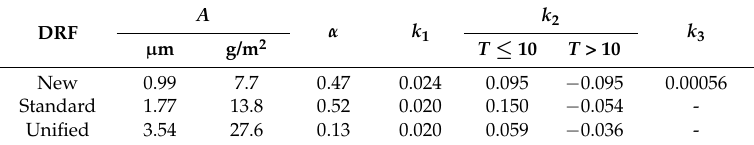
Table 7. Values of coefficients used in the nonlinear DRFs for carbon